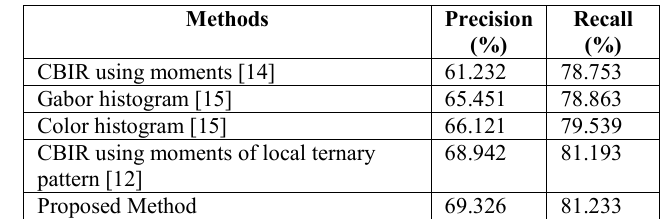
Table 3. Average precision and recall values for the proposed and other